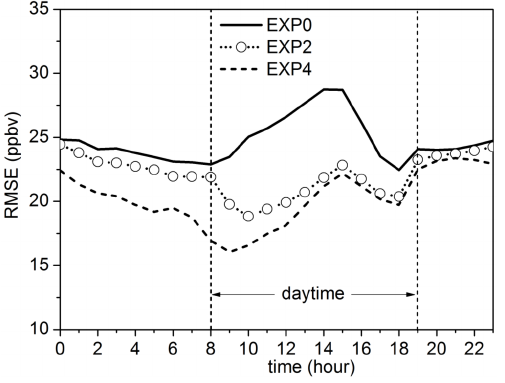
Fig. 5. Time series of hourly RMSE of 1-h ozone forecast in free run (solid line), EXP2 (dash line with circles) and EXP4 (dash line).